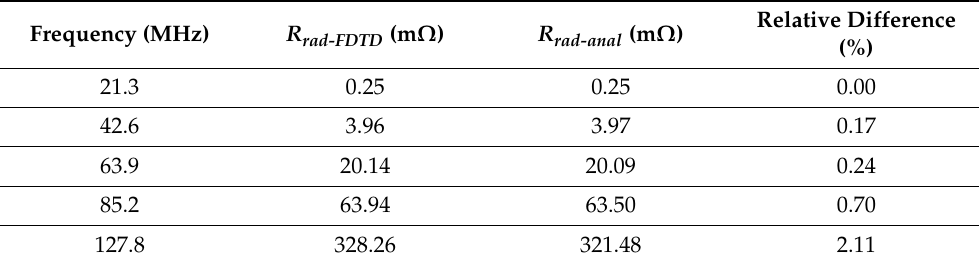
Table 9. Coil radiation resistance estimation for different frequencies ( n = 4-segment loop). FDTD and analytical calculation results.